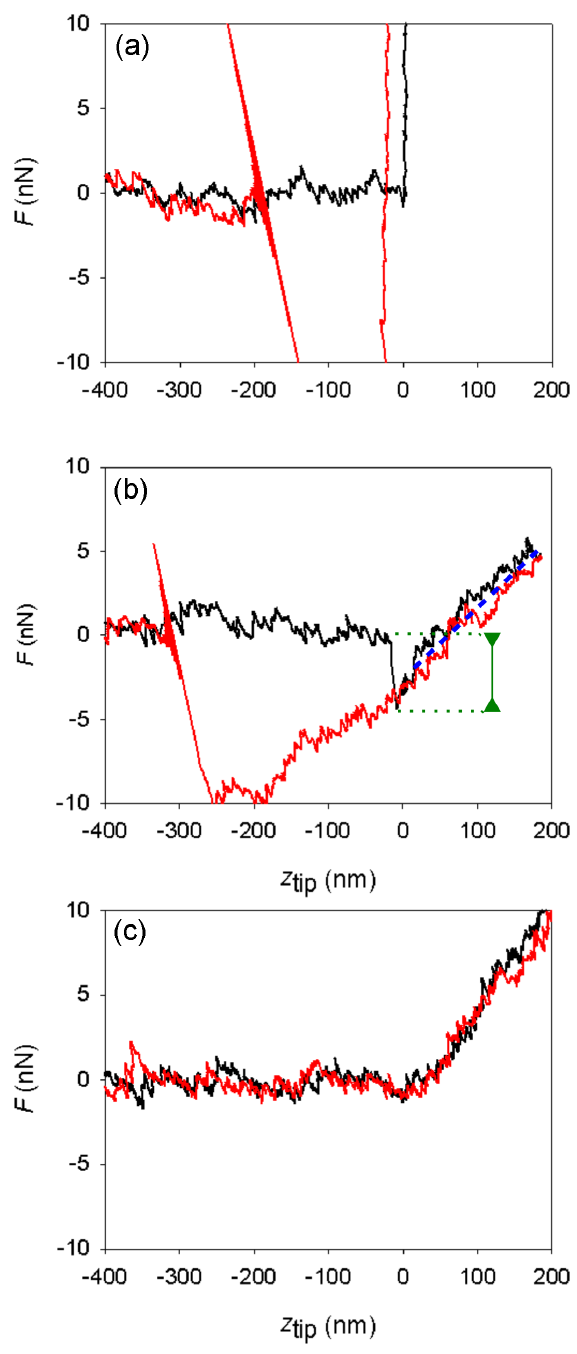
Figure 5. Different shapes of measured AFM force curves. (a) Mica, Environmental Chamber (EC), silicon tip. (b) Ice, EC, silicon tip. (c) Ice, Mini Environmental Chamber (mEC), platinum-coated silicon tip. Curves in black represent the approach branches and curves in red the retract branches. The green line marks the jump-in distance; the blue dotted line is parallel to the indentation